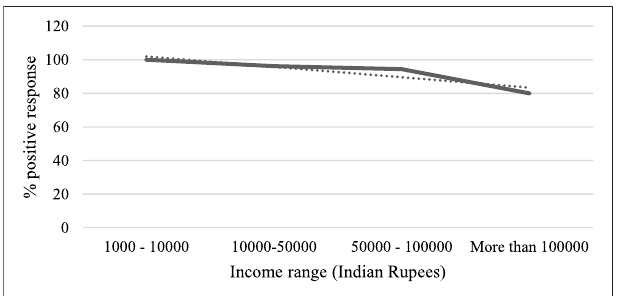
FIGURE 4 | Annual income vs. Outlook towards